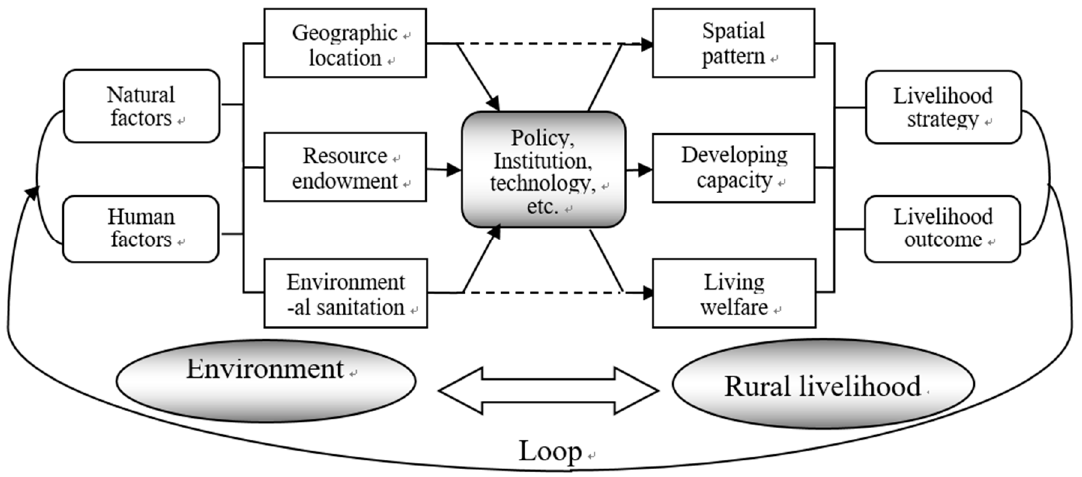
Figure 7. Livelihood–environment coupling mechanism at a village scale.